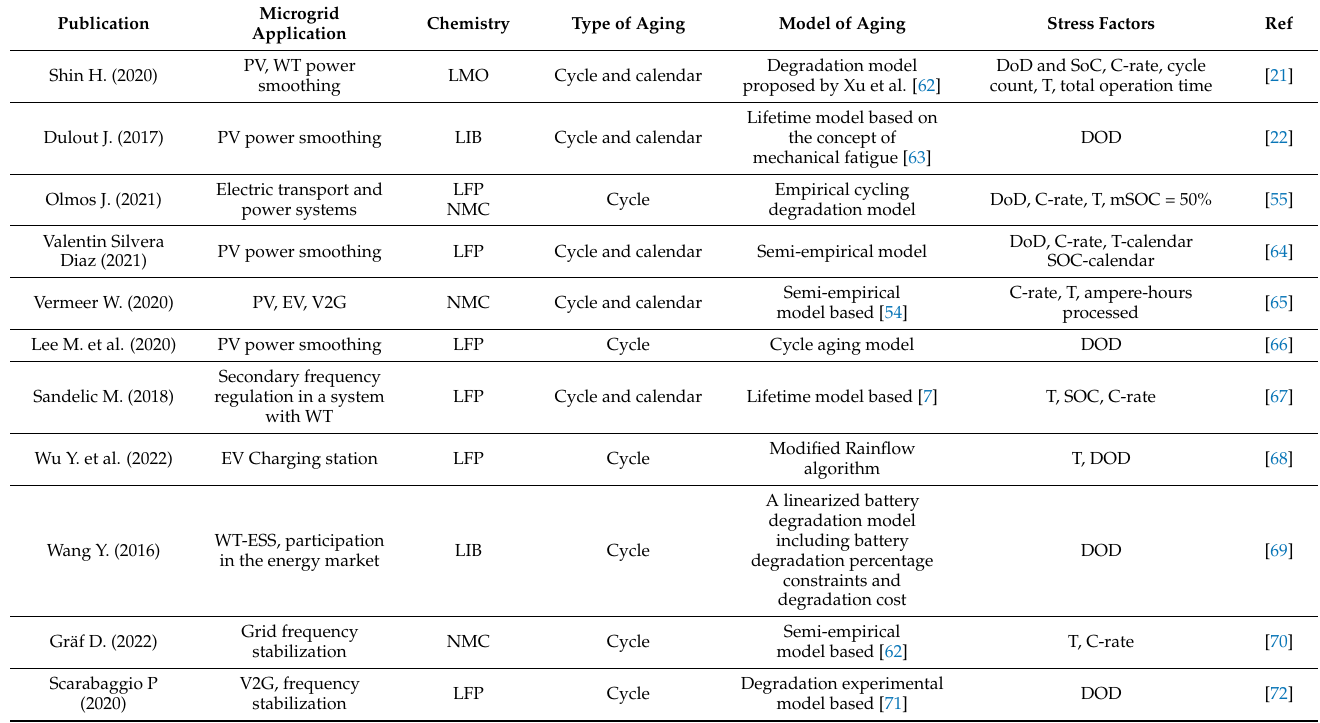
Table 2. Models of battery storage degradation in power